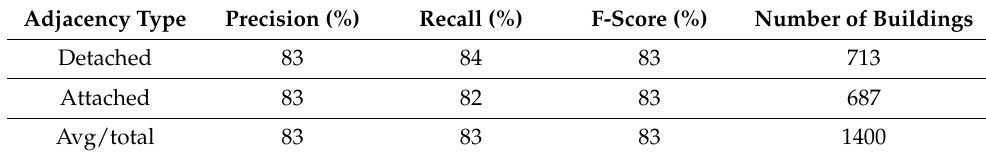
Table 3. Test results of the prediction scores at stage